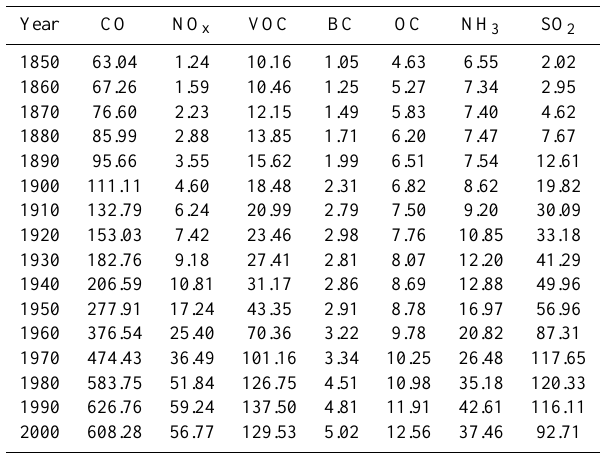
Table 7. Global amounts of emission from anthropogenic sources for each species considered in this